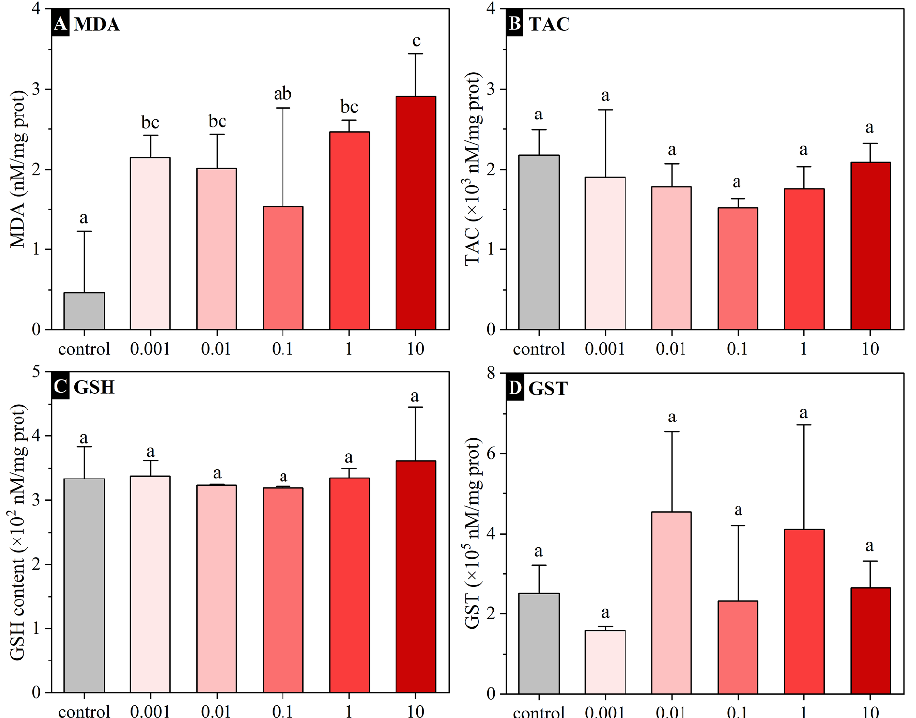
Figure 2. Nanoplastics effects on oxidative stress in larval medaka following 24 h exposure. ( A ) Malondialdehyde (MDA), ( B ) total antioxidant content (TAC), ( C ) reduced form of glutathione (GSH) level, and ( D ) glutathiones-transferase (GST) enzyme activity. Abundance values are expressed as mean ± standard deviation ( n = 3 replicates per treatment). Groups sharing the same lowercase letters are statistically similar to each other (one-way ANOVA, Tukey’s post hoc, p < 0.05). There is a close relationship between reactive oxygen species (ROS) metabolism and cell membrane damage, both of which are regulated by the levels of ATP amount and energy charge. As shown in Figure 3, our results show that ATP levels did not significantly decrease in fish larvae after 0.001–1 µ g/mL of PS nanoplastics exposure. However, at the highest exposure concentration (10 µ g/mL), there was a significantly higher ATP level when compared to controls ( p = 0.030) (Figure 3A). Similarly, nanoplastics also caused a significant increase in oxygen consumption of 124.1% ± 45.8% as compared to the control ( p = 0.047) at the 10 µ g/mL exposure level, but no significant change in the oxygen consumption after exposure to other exposure concentrations (Figure 3B). Cholesterol content in fish larvae did not significantly differ from controls, regardless of the concentration of nanoplastics (Figure 3C). There is also strong evidence to support the idea that this elevated ATP demand may serve to fuel ABC